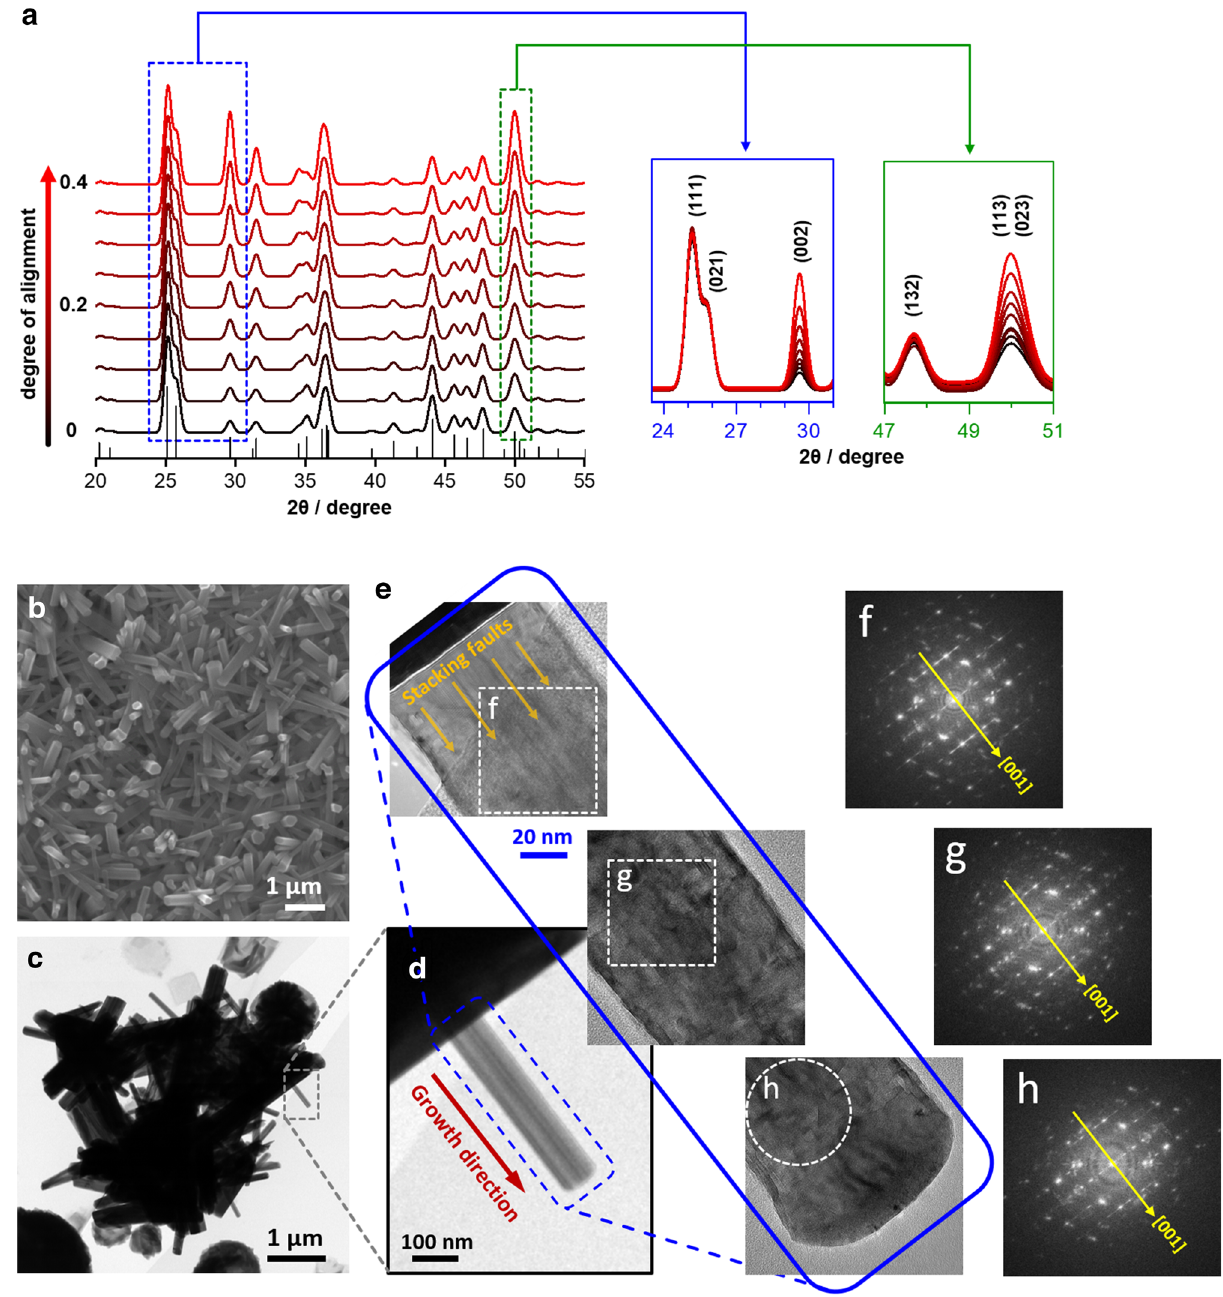
Figure 4. ( a ) Simulated XRD patterns of the SrCO 3 ( Pmcn ; orthorhombic; and D = 14 nm) with the preferred orientation along (002) plane (i.e., c -axis) as a function of the degree of alignment. The degree of alignment is represented by a fraction, with 0 indicating a completely random-oriented structure, and 1 being a fully oriented structure (e.g., precisely parallelly aligned rods). ( b ) SEM and ( c ) TEM images of SrCO 3 nanorods. ( d , e ) Low- and high-magnification TEM images of a single-crystalline SrCO 3 nanorod. ( f – h ) FFT diffraction patterns of selected areas in ( e ), indexed to the orthorhombic SrCO 3 ( Pmcn ; JCPDS No. 05-0418) (Supplementary Fig. S7 spots are indexed to the orthorhombic SrCO 3 ( Pmcn ; JCPDS No. 05-0418) where the streaks, lying parallel to the [010] direction, reflect local disorder of the atomic stacking (i.e., stacking faults) as being perpendicular to the fringes in the HR-TEM image (see Supplementary Fig. S7 online). The distance between the streaks, normal to the growth direction, corresponds to the (001) plane, i.e., 0.60 nm, demonstrating the growth direction of the nanorod to be (cid:31) 001 (cid:30) . Note that this kind of pattern appears in all regions of the nanorod (Fig. 4f–h). Hence, it is concluded that the SrCO 3 nuclei tend to assemble along the c -axis leaving stacking faults behind, which is in good agreement with the result from XRD simulation.